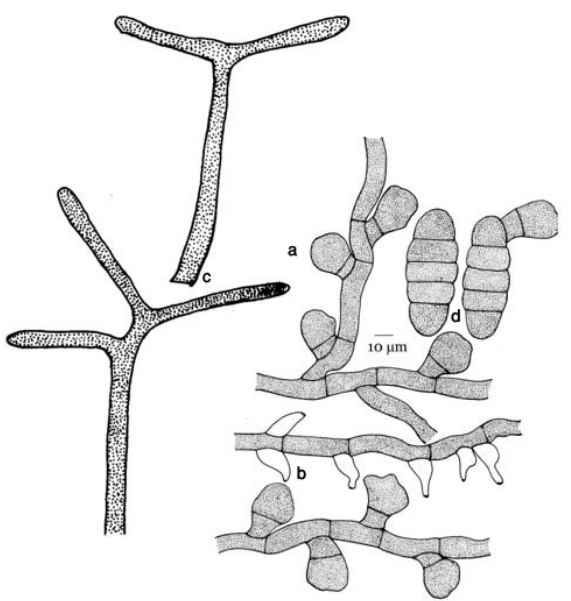
Figure 113. Meliola scleropyri a - Appressorium; b - Phialide; c - Apical portion of mycelial setae; d -